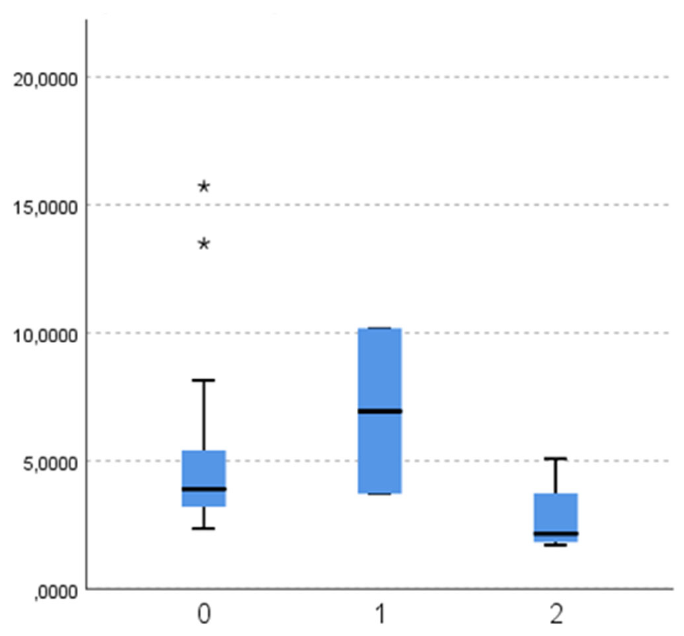
Figure 3. Diameter (mm) of chewed particles (y-axis) according to the aetiology of antagonistic contact loss (x-axis: 0—tooth extraction (subgroup 2a), 1—malocclusion (2b), 2—changing dentition (2c)). (* ‐ outliers)